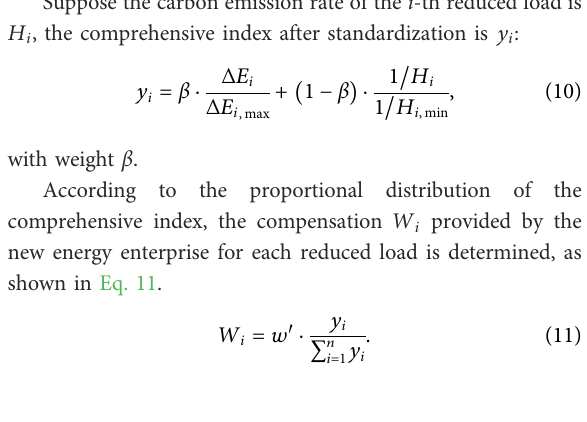
FIGURE 5 Flow chart of the power-balancing compensation